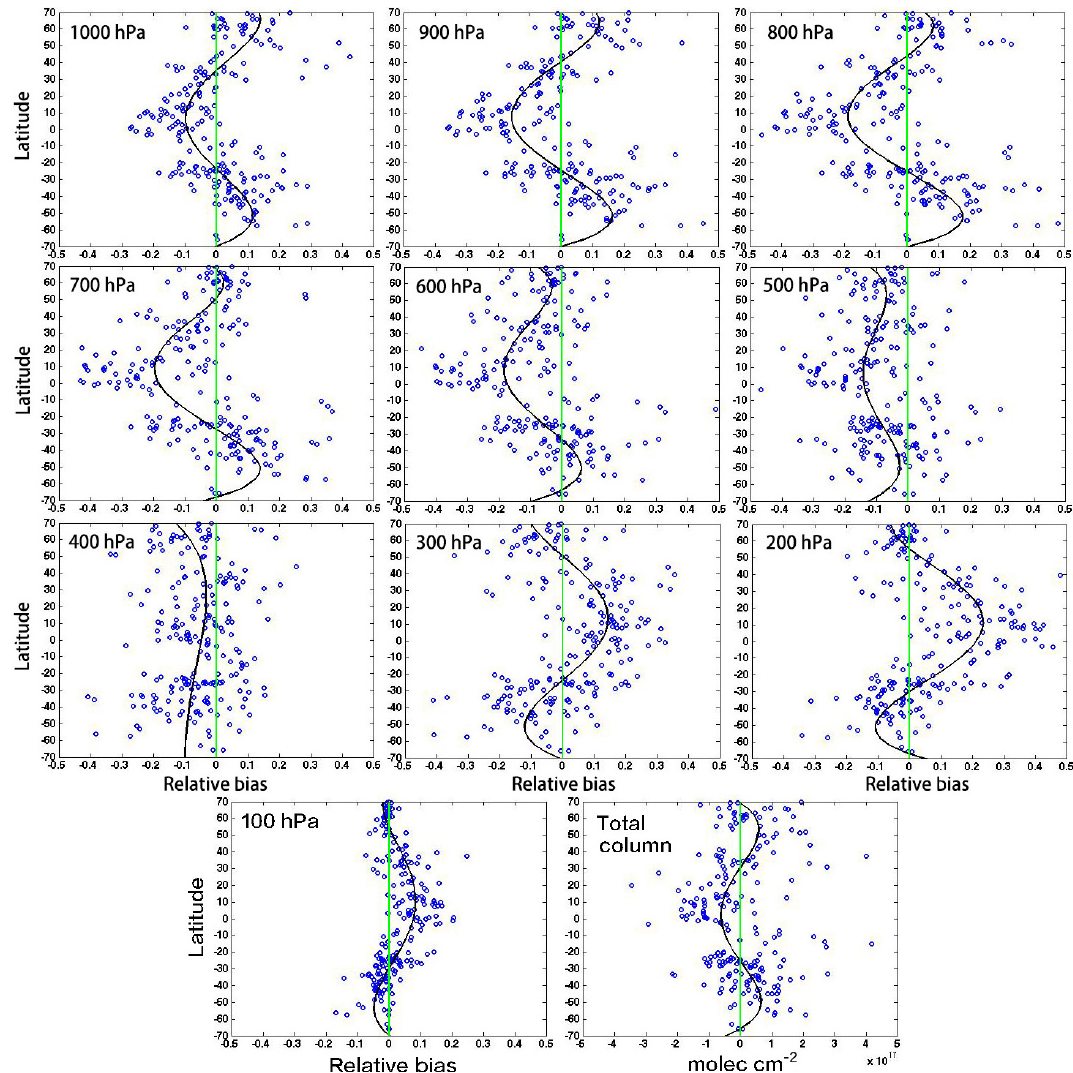
Figure 1. Difference between MOPITT CO retrievals and HIPPO aircraft measurements. The aircraft measurements are smoothed with MOPITT averaging kernels. The black solid line shows the 4-order polynomial curve fitting which is used to correct MOPITT data in this